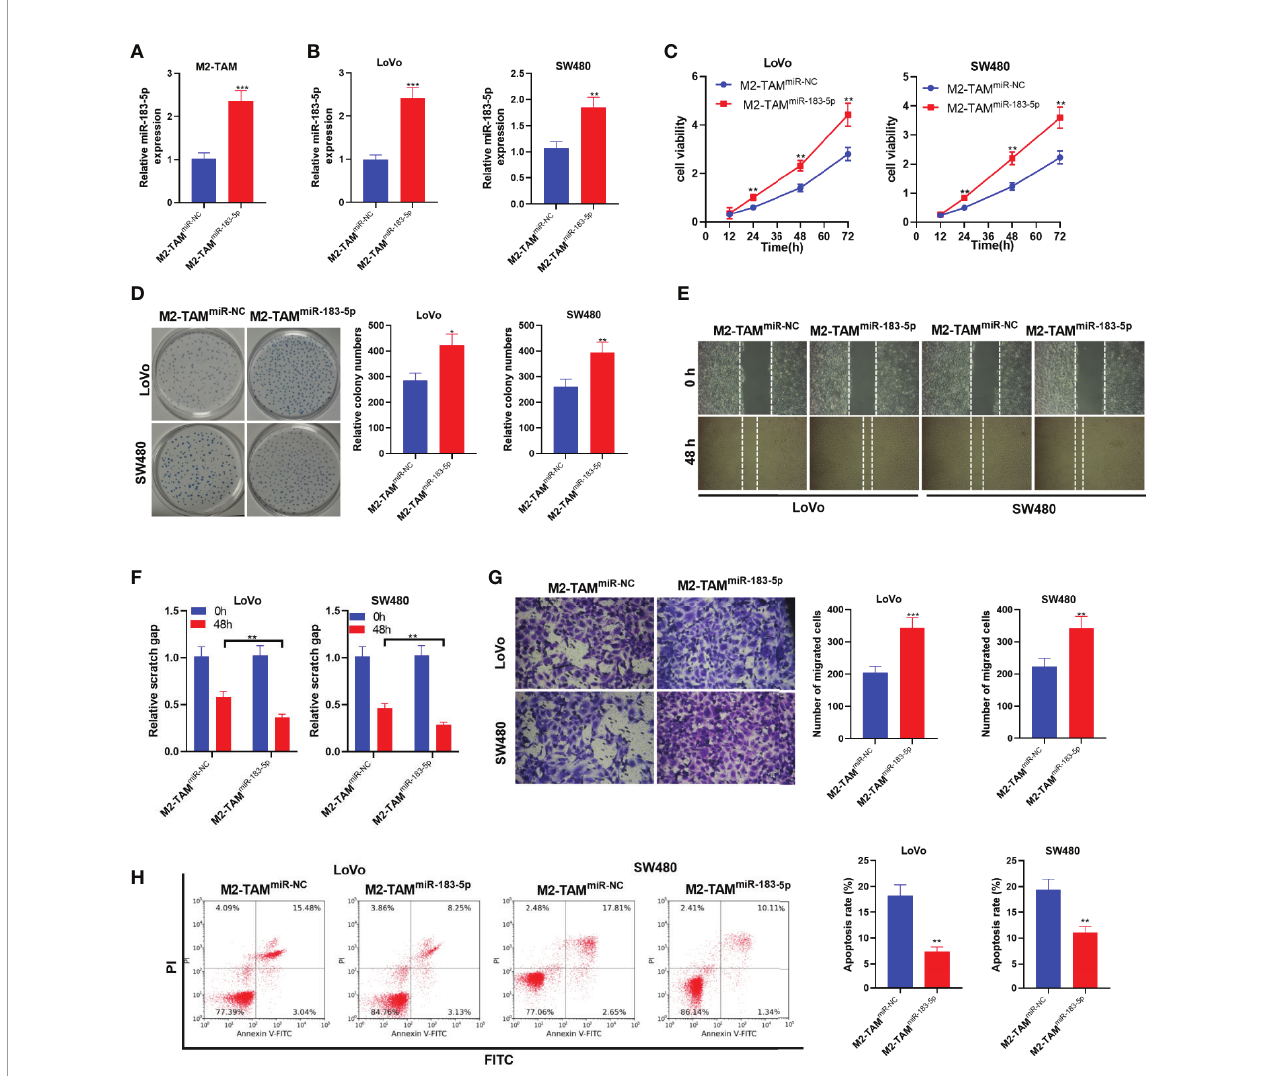
FIGURE 3 | M2-TAM-Exo overexpressing miR-183-5p promoted the malignant phenotype in CC cells. Cisplatin (5 m m) was used for inducing apoptosis of LoVo and SW480 cells. M2-TAM overexpressing miR-183-5p were co-cultured with LoVo and SW480 cells, respectively. (A) The miR-183-5p level in M2-TAM was monitored by qRT-PCR. (B) The miR-183-5p pro fi le in LoVo and SW480 cells was monitored by qRT-PCR. (C, D) CCK-8 assay and colony formation assay were implemented to test CC cell proliferation. (E) The ability of cell colony formation was tested. (F) Wound healing test detected cell migration. (G) Cell invasion was measured by Transwell assay. (H) Cell apoptosis was veri fi ed by FCM. * P < 0.05, ** P < 0.01, *** P < 0.001 ( vs . The M2-TAM miR-NC group).